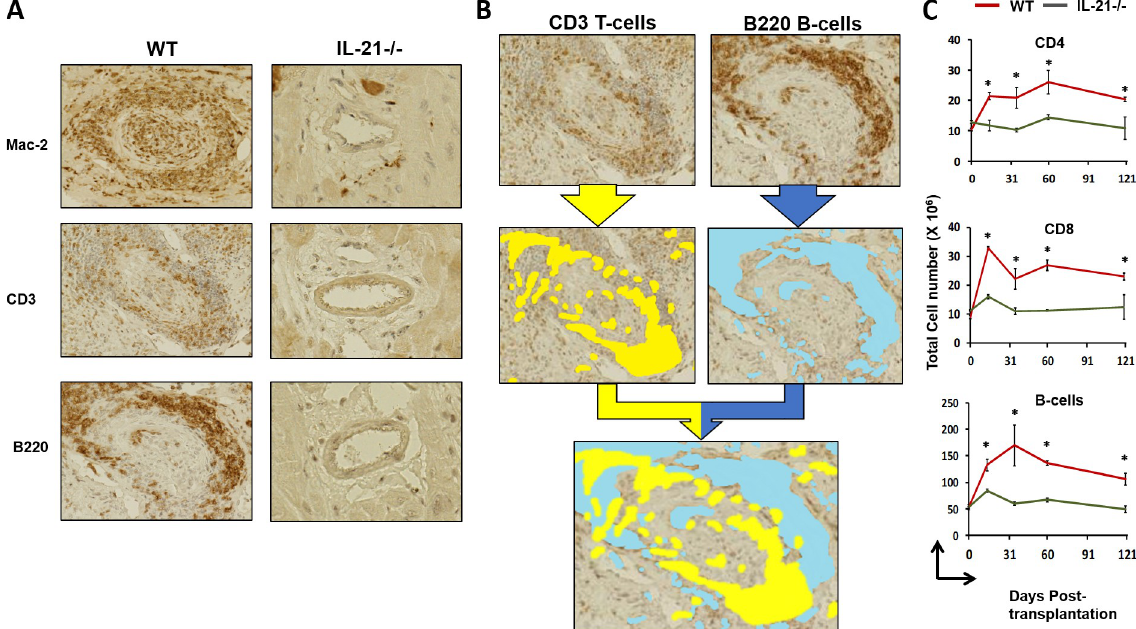
Fig 3. Immune cell infiltration of grafts in IL-21-/- mice in a chronic rejection model. A) Representative images of IHC stained vessels in grafts of heart transplants from bm12 mice in WT or IL-21-/- recipient mice (n = 3 mice/group). Stains were as follows: MAC2, macrophages; CD3, T-cells; B220, B-cells. B) Organization of CD3 stained T-cells and B220 stained B-cells near vessel with possibility of tertiary lymphoid organ like development. C) Accumulation of immune cells detected by flow cytometry of spleen homogenates. Significance approximated by unpaired Student’s t-test, � indicates p <